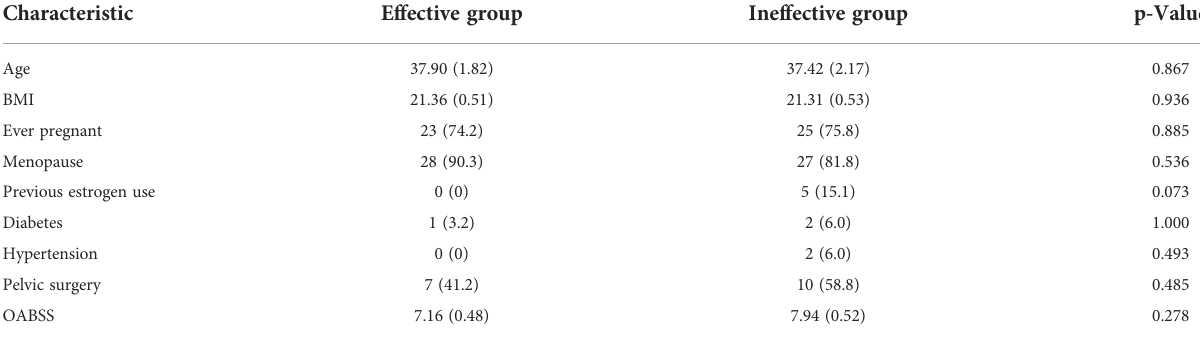
TABLE 1 Comparisons of characteristics between effective group and ineffective group.